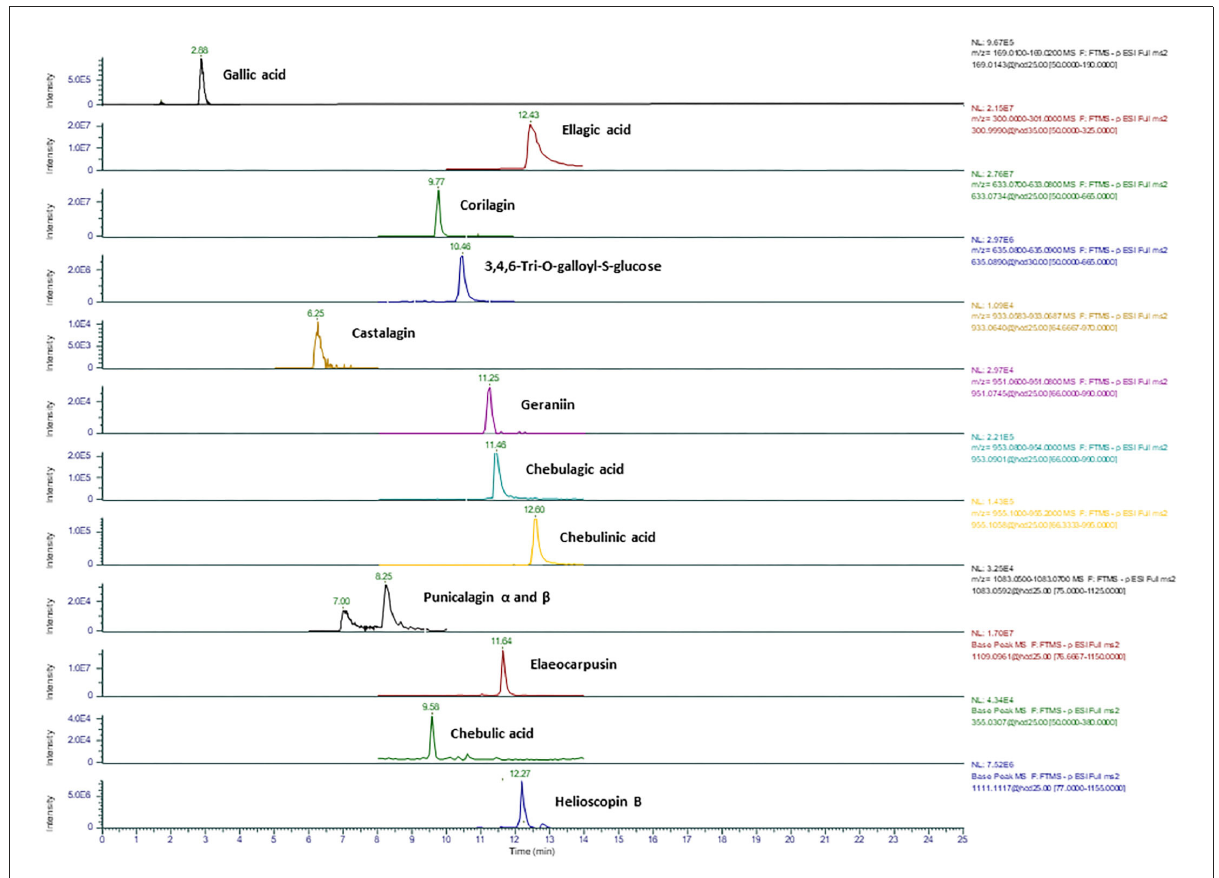
FIGURE2 Representative ion chromatograms of 13 main hydrolysable tannins and phenolic acids detected in Kakadu plum fruit using an HRAM Orbitrap mass spectrometer.